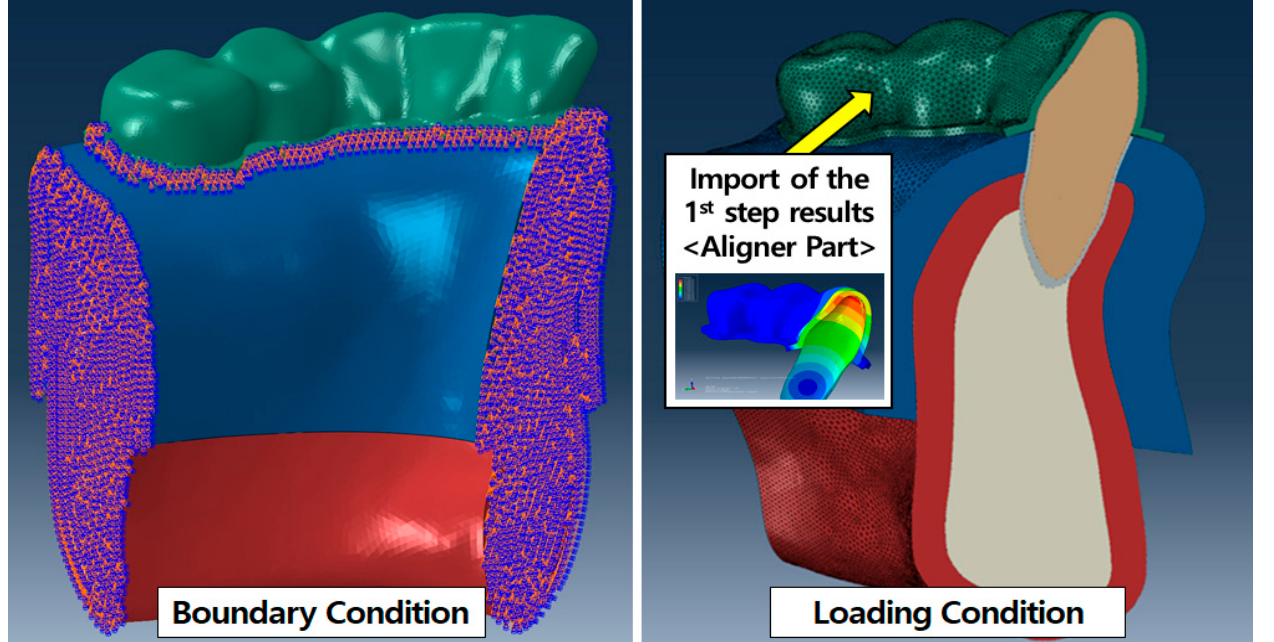
Figure 5. Loading and boundary condition of the 2 nd step in FEA.